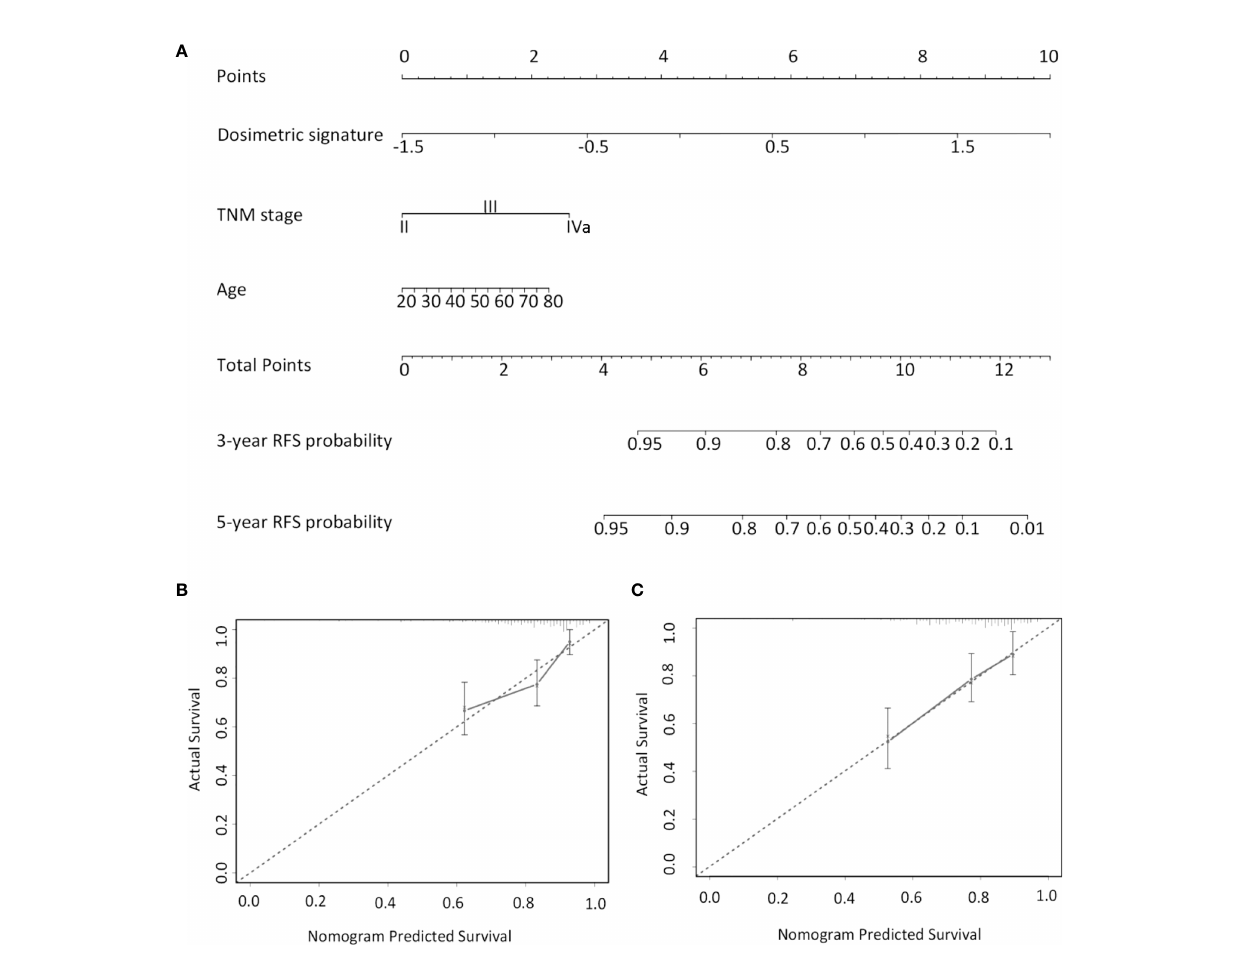
FIGURE 3 | Nomogram for predicting 3- and 5-year RFS. (A) For each patient, the values of three variables (age, TNM stage, and dosimetric signature) are represented as points by projecting them onto the upper-most line (point scale). Summing the three variables and projecting the total points value downward onto the bottom-most line can determine the probability of 3- and 5-year RFS. Calibration curves of the nomogram in predicting 3- (B) and 5-year RFS (C) . The X-axis indicates the predicted probabilities of RFS, while the y-axis shows the actual RFS. RFS, relapse-free